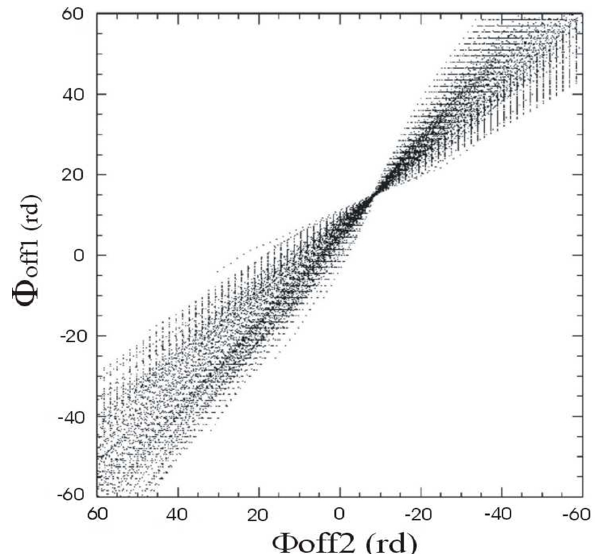
Figure 7. Example of the combined phase-offset functions (CPOFs) of the two